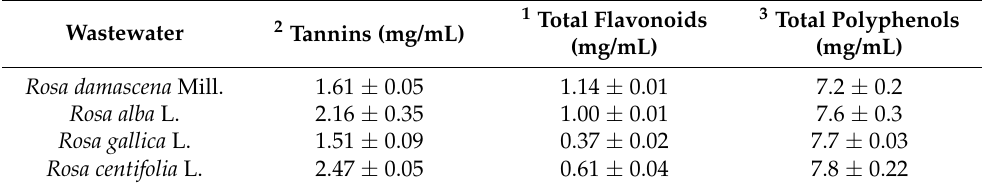
1 Total Flavonoids 3 Total Polyphenols (mg/mL) (mg/mL)